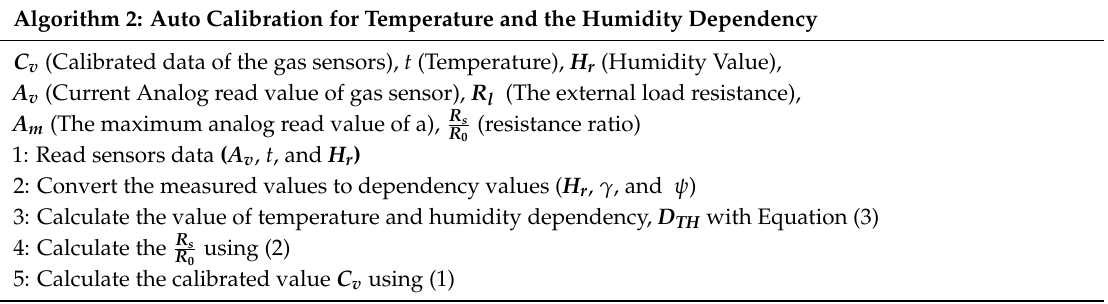
Algorithm 2: Auto Calibration for Temperature and the Humidity Dependency C v (Calibrated data of the gas sensors), t (Temperature), H r (Humidity Value), A v (Current Analog read value of gas sensor), R l (The external load resistance), A m (The maximum analog read value of a), R s (resistance R 0